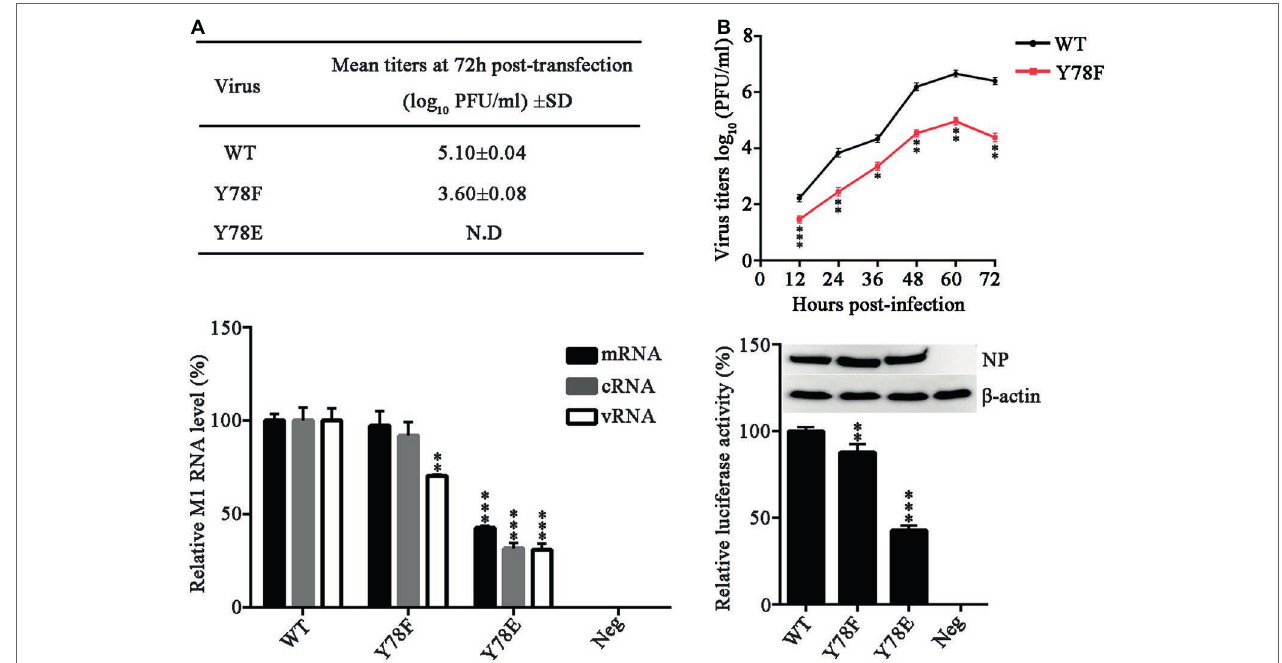
FIGURE 2 | NP Y78 phosphorylation affects IAV replication and polymerase activity. (A) Rescue of WT and Y78 mutant WSN viruses using the 12-plasmid reverse genetic system. The supernatants of 293 T cells were harvested at 72 h.p.t. and used for plaque assays in MDCK cells. N.D represents failed rescue; SD represents standard deviation. (B) Multi-cycle growth curves of viruses. A549 cells were respectively infected with WT and Y78F mutant WSN viruses (MOI = 0.001). Then the supernatants of virus-infected cells were examined by plaques assays at different time points. Data are shown as mean + SD ( n = 3). Difference between WT and Y78F mutant viruses was tested using unpaired Student’s t -test. * p < 0.05; ** p < 0.01; *** p < 0.001. (C) The expression levels of M1 RNAs (mRNA, cRNA, and vRNA) were tested by real-time PCR. 293 T cells were transfected with the 12-plasmid reverse genetic system containing NP WT, Y78E, Y78F, or empty vector (Neg) plasmid for 48 h. Data are shown as mean + SD ( n = 3). Differences between mutant and WT NPs were evaluated using one-way analysis of variance (ANOVA) followed by Dunnett’s test. ** p < 0.01; *** p < 0.001. (D) The polymerase activity of WT and mutant NPs were determined by luciferase assays. Luciferase activity was measured at 30 h after transfection of viral proteins (PB1, PB2, and PA); β -gal; and the cNS-Luc plasmid in 293 T cells. Differences of luciferase activities between the mutant and WT NPs were evaluated using one-way ANOVA followed by Dunnett’s test (below). Data are shown as mean + SD ( n = 3). ** p < 0.01; *** p < 0.001, and the expressions of NPs were analyzed by western blotting